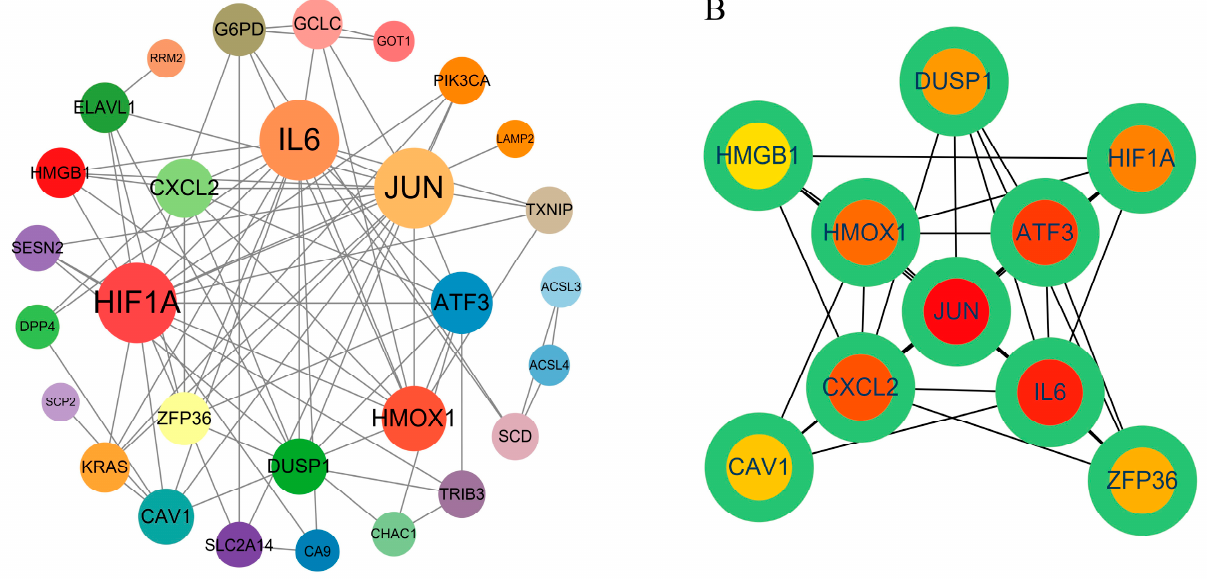
Table 2. CMap prediction of the top 10 drugs for fluorosis treatment.